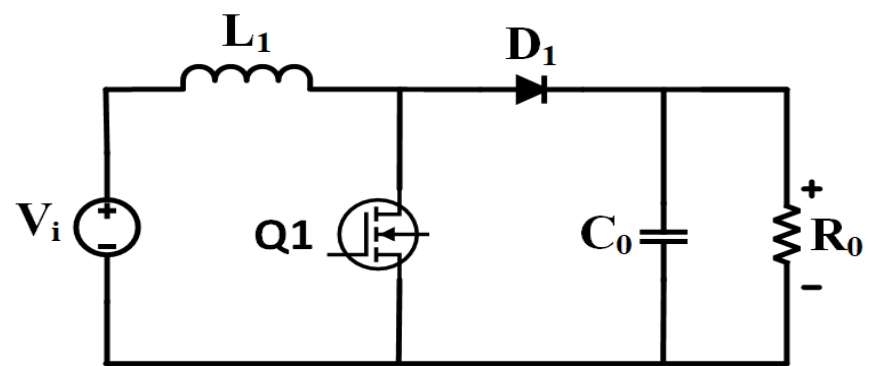
Figure 5. DC-DC boost or step-up converter.